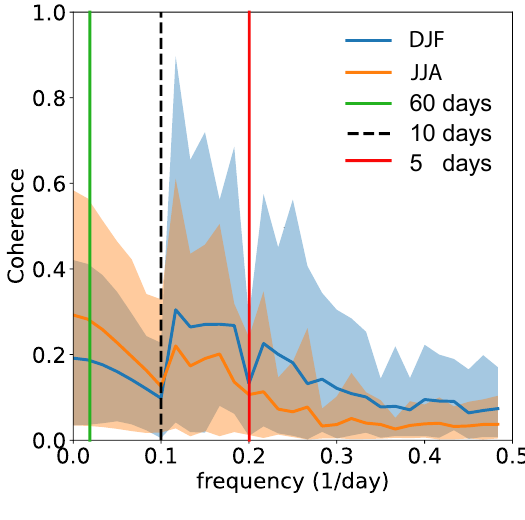
Figure 18. Absolute value of the coherence between the westward inertio-gravity and Kelvin wave zonal wind fields at 200 hPa, averaged from 5S to 5N, from 1980 to 2010. The frequency of 1 refers to the minimum frequency